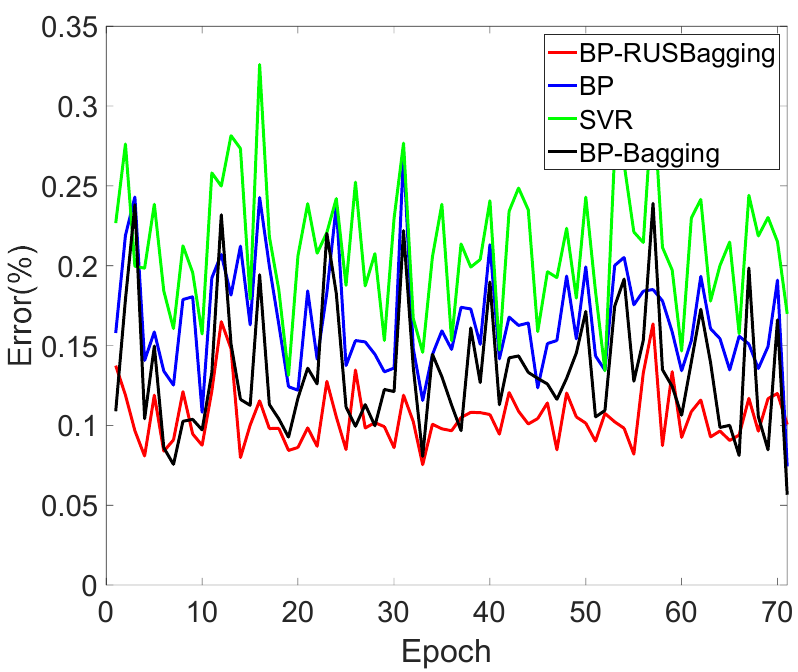
Figure 7. MAPE results of each method on the whole test set. Table 3. Comparison of the performance of different methods on the minority test